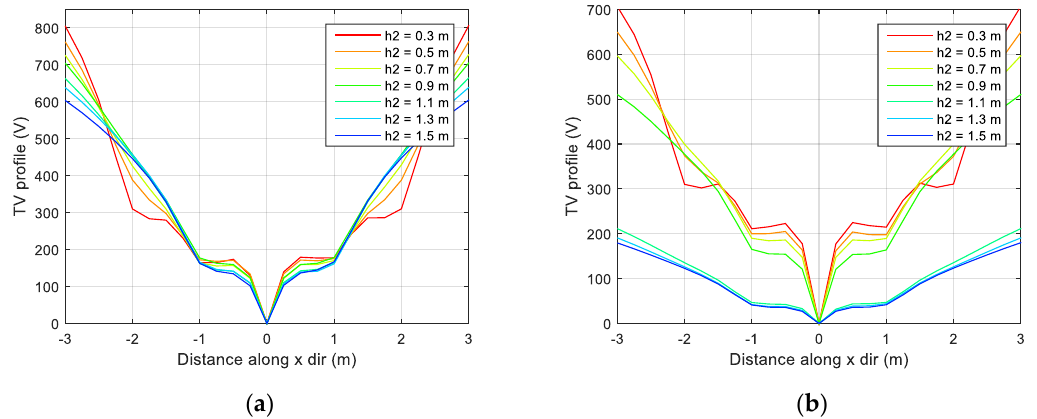
Figure 4. EPR, 500 Ω m / 100 Ω m / 2 m, D 1 = 2 m, D 2 = 4 and 5 m. Figure 4. EPR, 500 Ω m/ 100 Ω m/ 2 m, D 1 = 2 m, D 2 = 4 and 5 m.